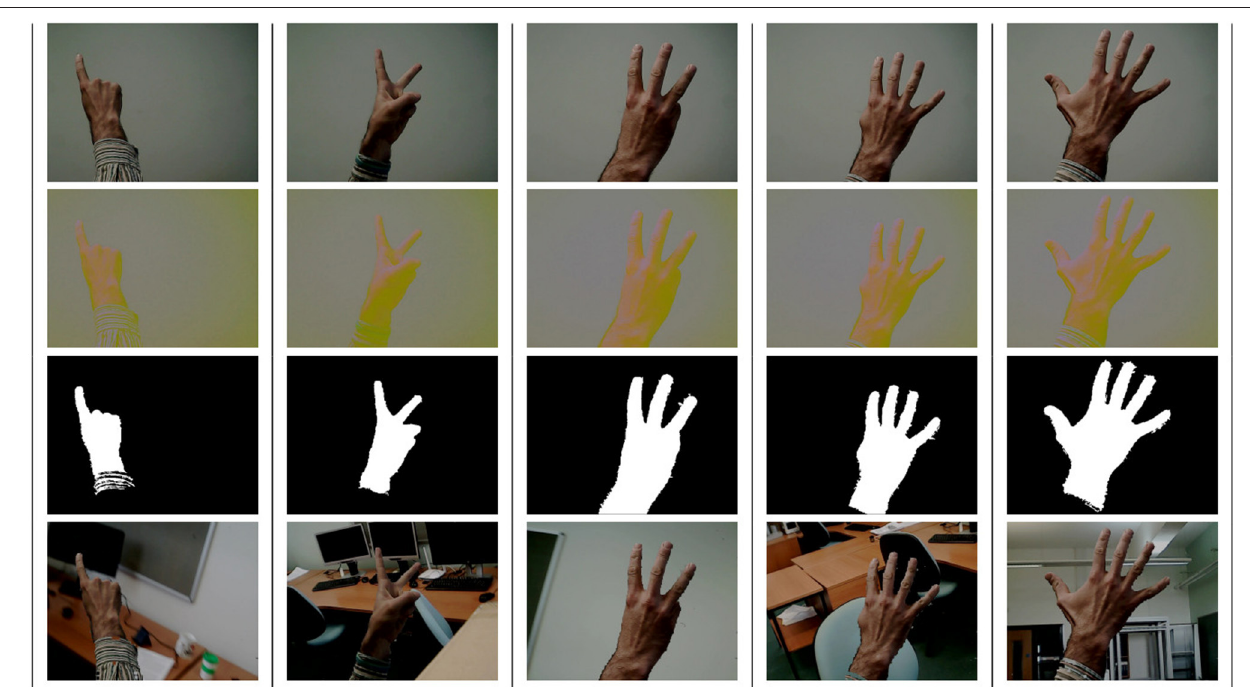
FIGURE 1 | A sample of human hand images from the dataset, with columns representing numbers from 1 to 5. Each row represents one or more stages from the previous list: the first row contains original images; the second row shows the images converted from RGB to YUV; the third row shows the mask that is applied for noise removal; finally, the fourth row shows the extracted hand region using the silhouette and applied to a different